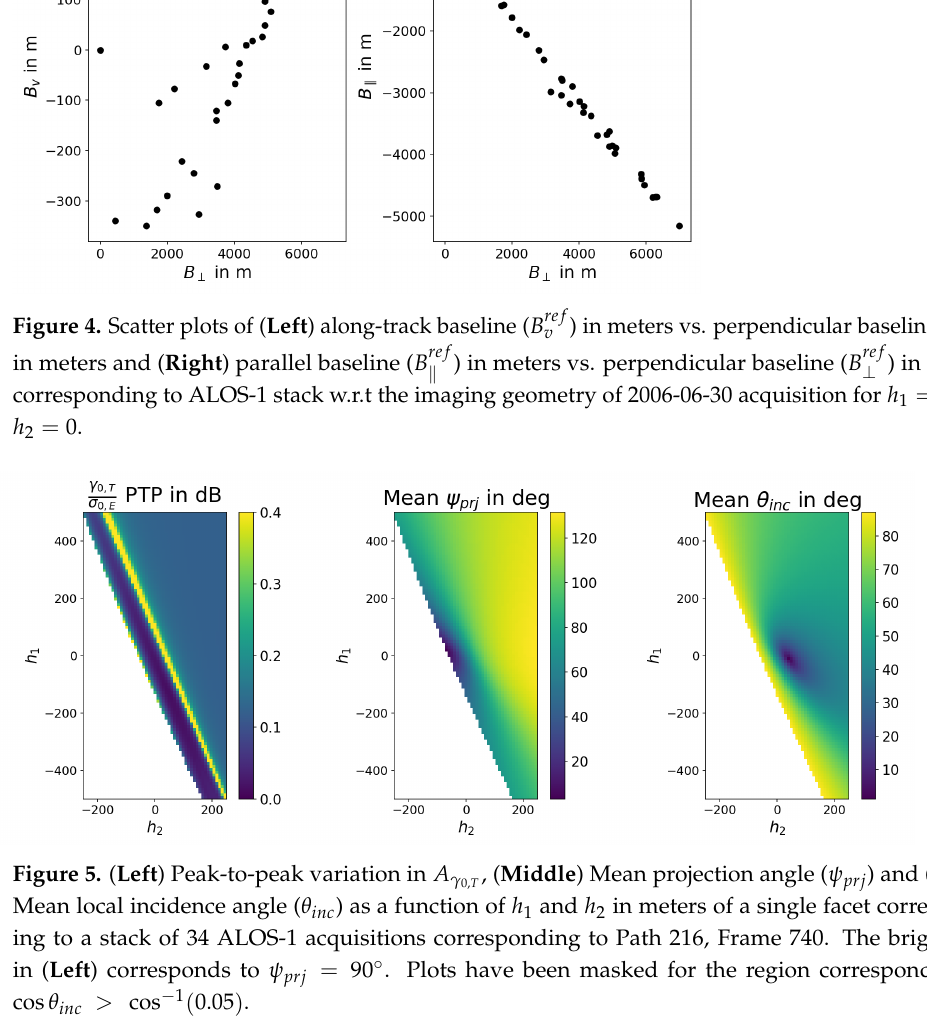
Figure 5. ( Left ) Peak-to-peak variation in A γ , ( Middle ) Mean projection angle ( ψ prj ) and ( Right ) 0, T Mean local incidence angle ( θ inc ) as a function of h 1 and h 2 in meters of a single facet correspond- ing to a stack of 34 ALOS-1 acquisitions corresponding to Path 216, Frame 740. The bright line in ( Left ) corresponds to ψ prj = 90 ◦ . Plots have been masked for the region corresponding to cos θ inc > cos − 1 ( 0.05 )